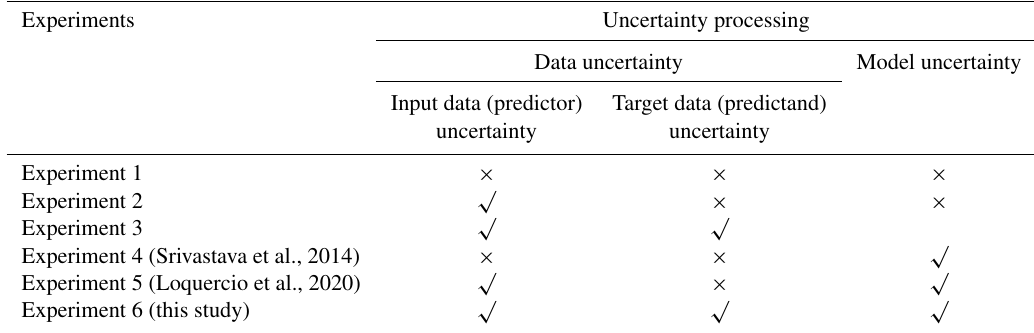
√ and × symbols indicate that the specific factor is considered and omitted,